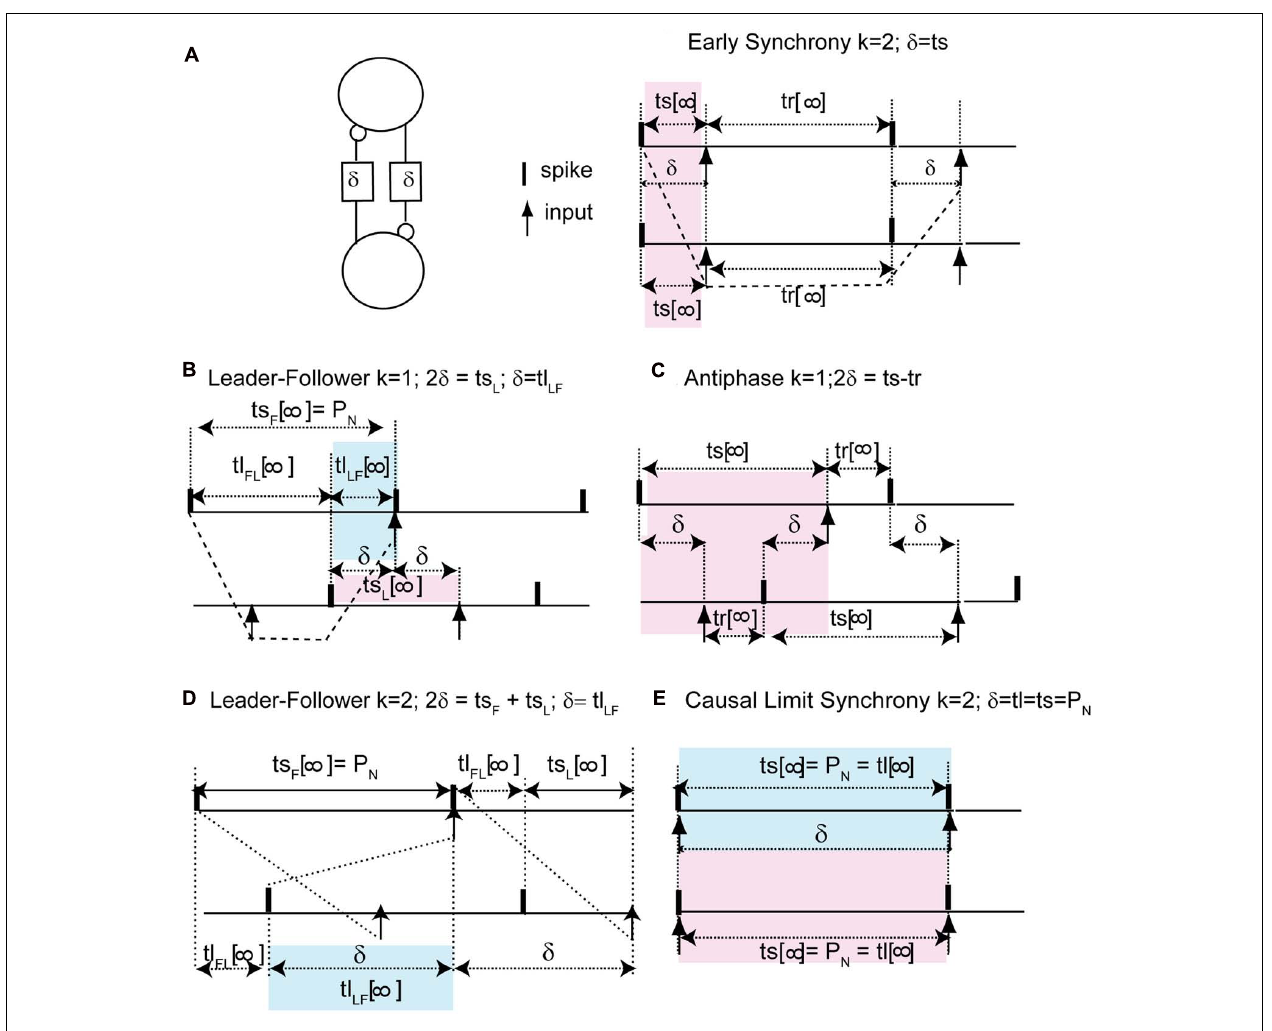
in the leader is twice the delay.The dashed lines show that the first spike in the top neuron does affect the timing of the very next spike in the same neuron, so k = 1. (C) Antiphase. For identical oscillators, both stimulus intervals are equal to twice the delay plus the recovery interval. (D) In the leader–follower mode for k = 2, the sum of the stimulus intervals is twice the delay, hence their average gives the delay. (E) Causal limit synchrony for long delays. In this case the stimulus intervals in both neurons are equal to the delay as in (A) , but because the recovery intervals are equal to 0, the stimulus intervals are also equal to both the network period and the delay.The delay is also equal to one time lag if the other is considered to be